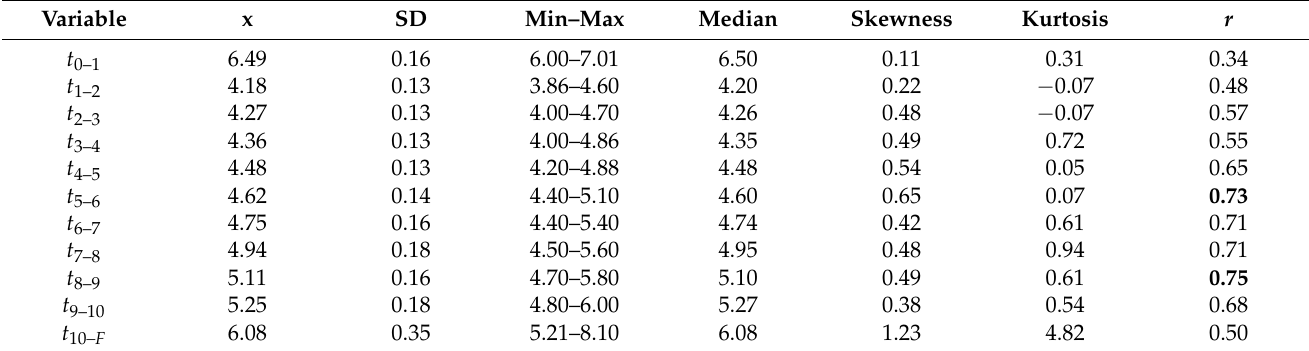
Table 3. Descriptive statistics of basic temporal variables (IHU) in the entire group of